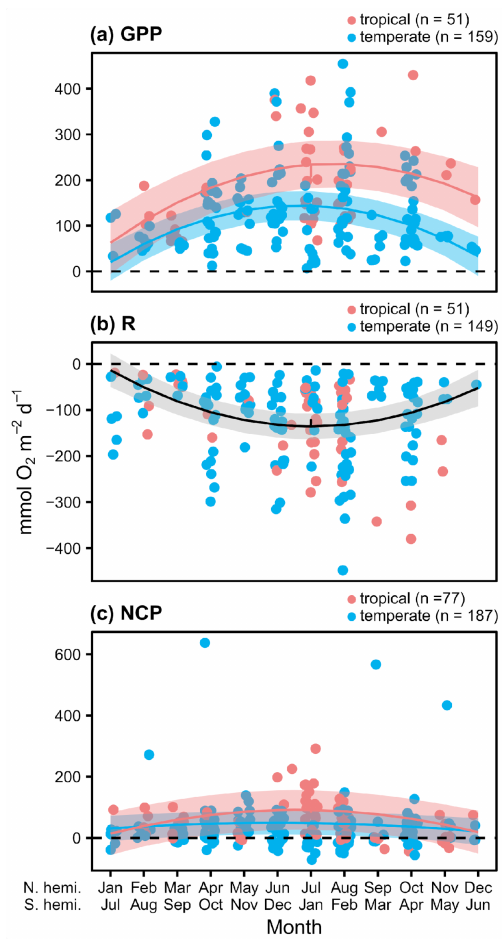
Figure 3. Daily rates for O 2 fluxes (mmolm − 2 d − 1 ) associated with seagrass communities as a function of time. Studies performed in temperate versus tropical ecosystems are illustrated by color (blue is temperate, red is tropical), and significance ( P < 0 . 05) is denoted by a fit line with a quadratic term and 95% CI. The colors of the lines denote significant differences between tropical and temperate systems.